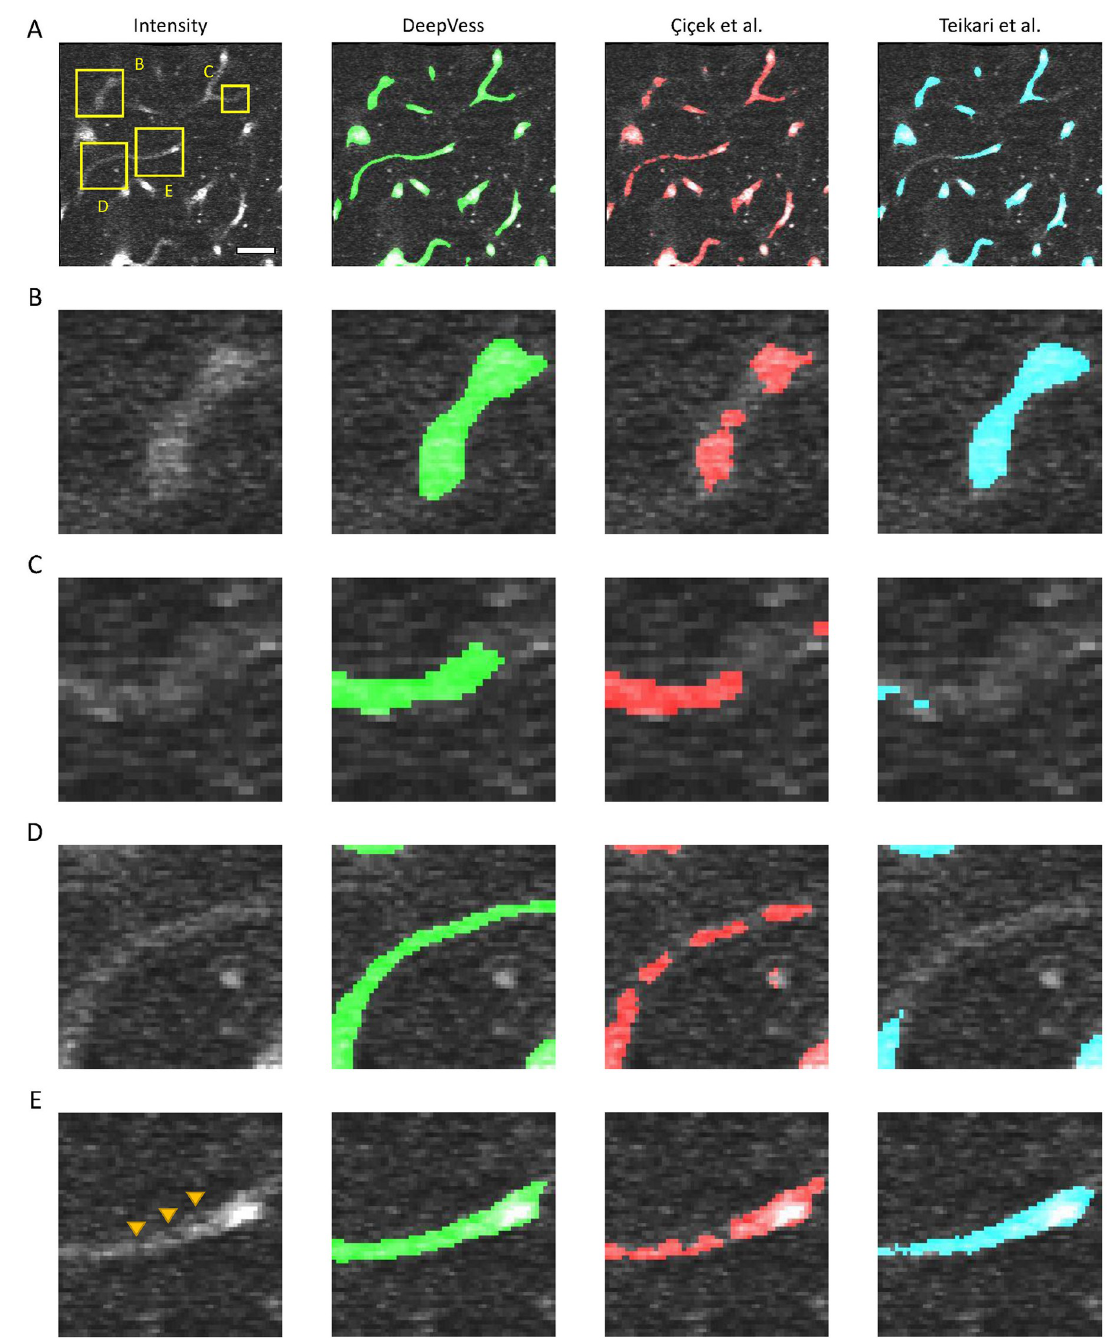
Fig 4. Comparison of DeepVess and the state-of-the-art methods [24, 28] in a 3D image cross-section obtained from an independent dataset (S4 Table #1) not used during the training. (A) An image frame with intensity in gray and overlay of segmentation from each method. (B-E) magnified view of four cases within A. The three models overlaid on the complete 3D image is made available online in Supplemental Materials. Scale bar is 50 μm .